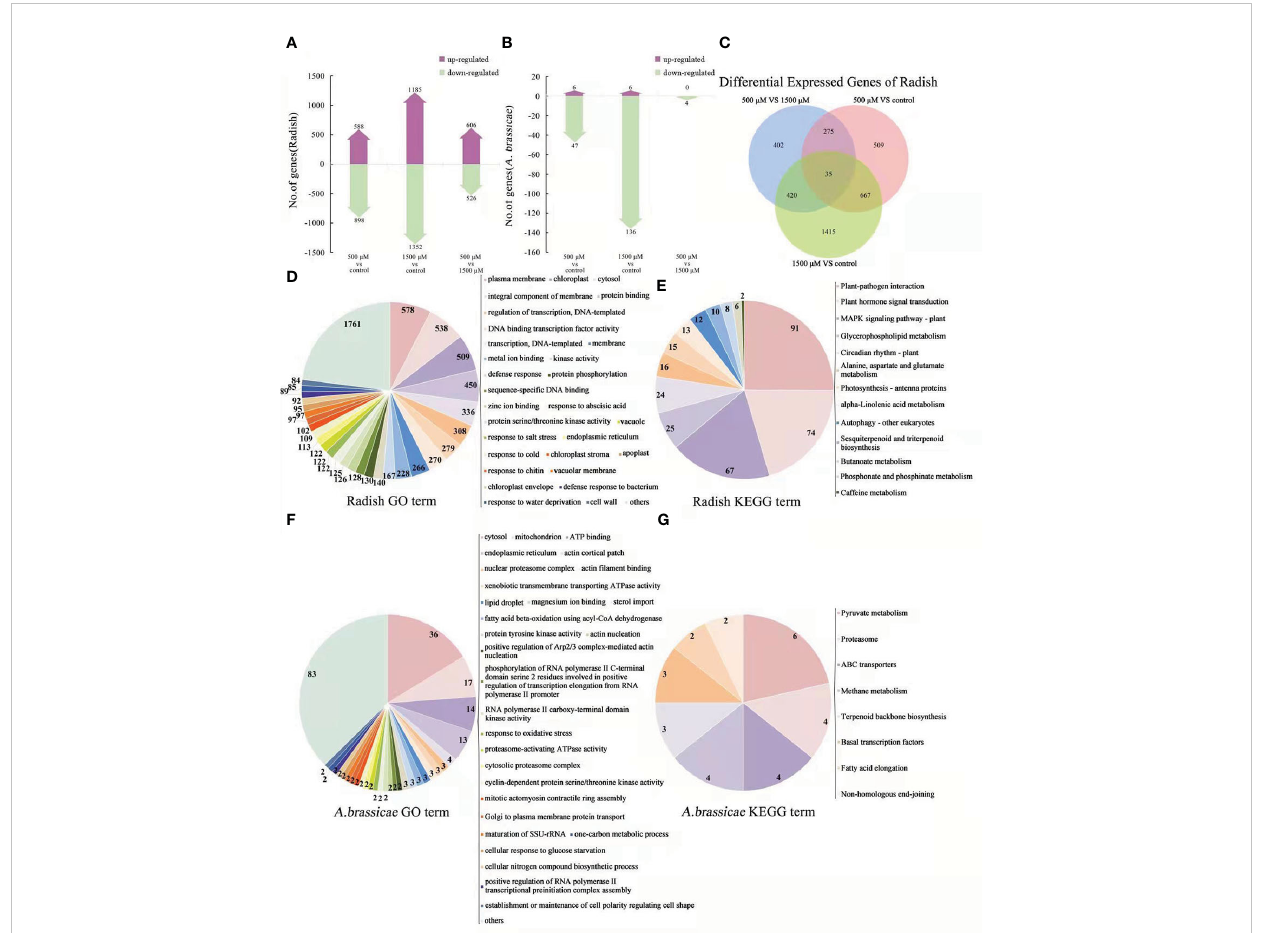
FIGURE 6 Analysis and functional categories of DEGs of radish “ JNYB ” and A brassicae from 0, 500, and 1500 m M MT treated diseased radish leaves. (A) and (B) : Number of genes up- and down-regulated of contrast sets of 500 m M MT treated group VS control, 1500 m M MT treated group VS control, and 1500 m M MT VS 500 m M MT treated group of radish and A brassicae . (C) Overlapping gene analysis of radish DEGs. (D, E) : Main functions of radish “ JNYB ” DEGs annotated by GO classi fi cation and KEGG pathway analysis. (F, G) : Main functions of DEGs of A brassicae annotated by GO classi fi cation and KEGG pathway